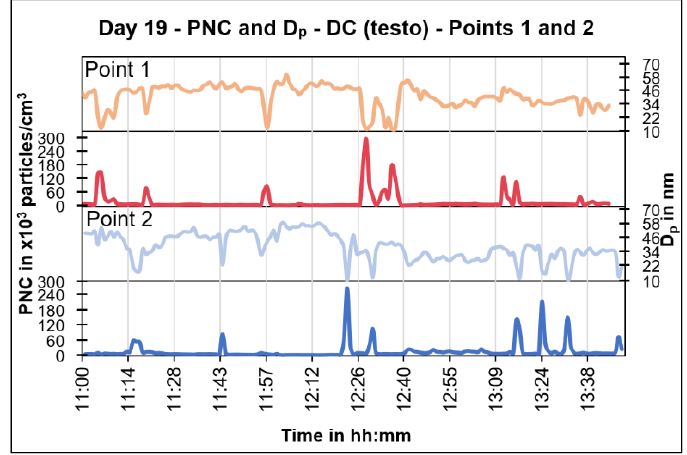
Figure 14. Day 14 PNC and D p results.